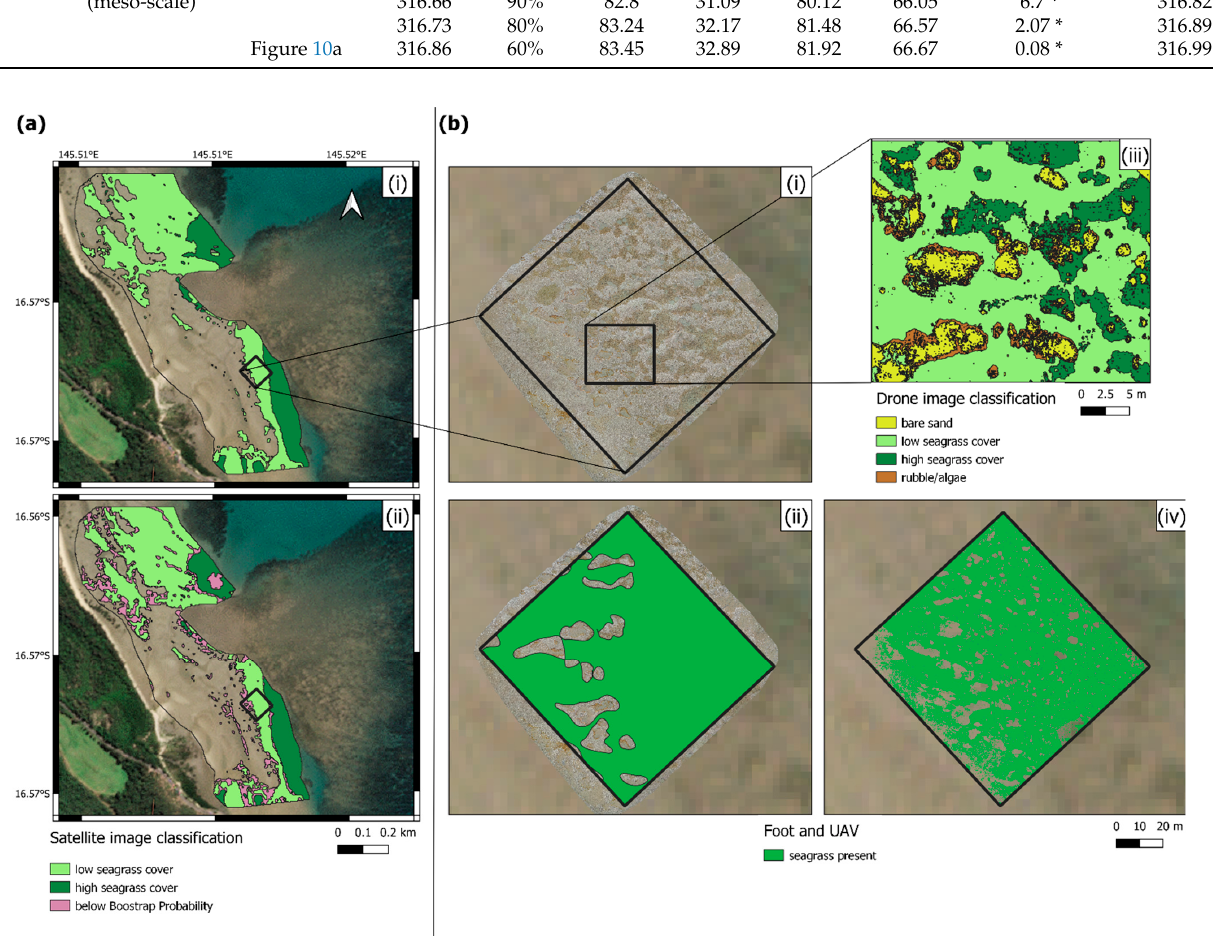
Figure 9. Machine ‐ and deep ‐ learning approaches to meso ‐ and fine ‐ scale mapping of seagrass abundance classes in a coastal clear water habitat (Yule Point) in 2019–2020: ( a ) meso ‐ scale map from spaceborne ‐ captured imagery showing seagrass abundance classes with ( i ) bootstrap probability of 60% and ( ii ) 100%; ( b ) fine ‐ scale maps showing ( i ) UAV ‐ captured image of AOI; ( ii ) presence of seagrass mapped in situ by foot; ( iii ) abundance classes of seagrass mapped using deep ‐ learning; ( iv ) presence of seagrass mapped using deep ‐ learning, within highlighted section of AOI.